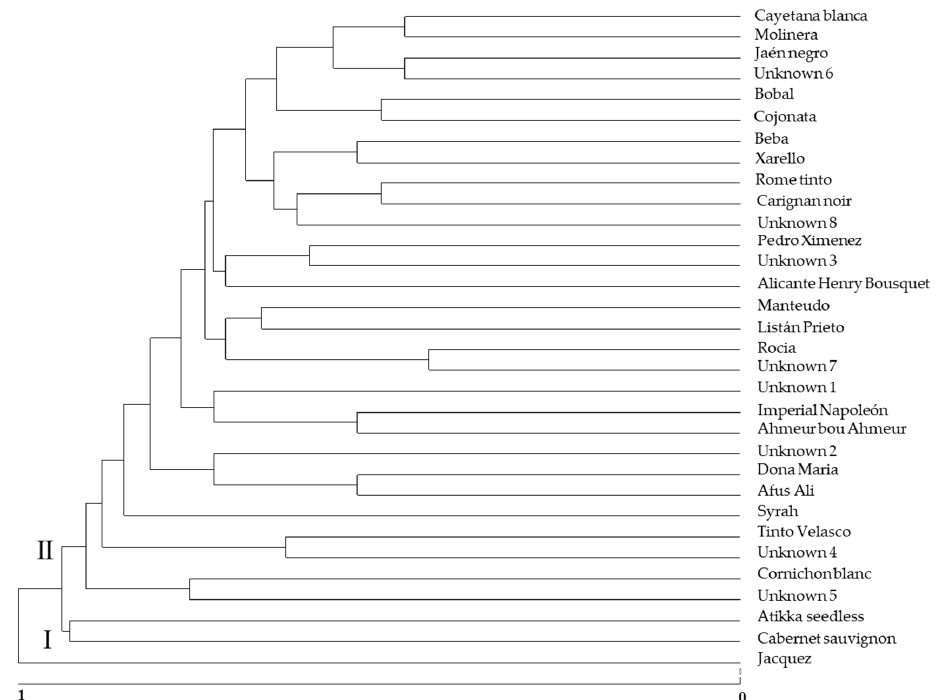
Figure 1. Genetic relationships among the thirty genotypes obtained and two reference cultivars.